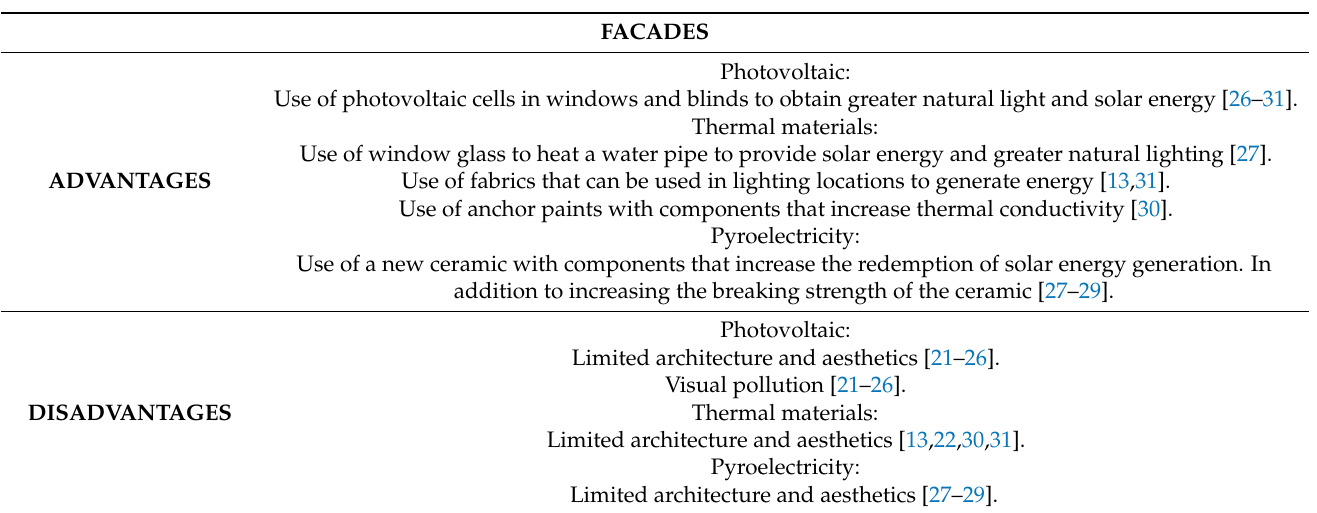
Table 1. Advantages and disadvantages of